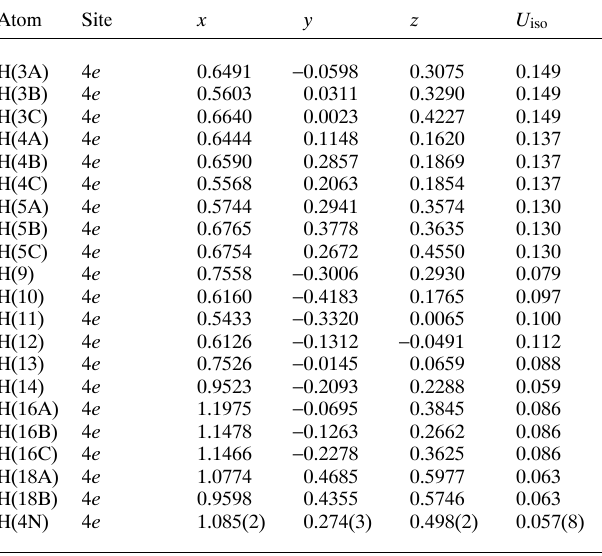
Table 2. A tomic coordin a tes a nd displ a cement p a r a meters (in Å 2 )